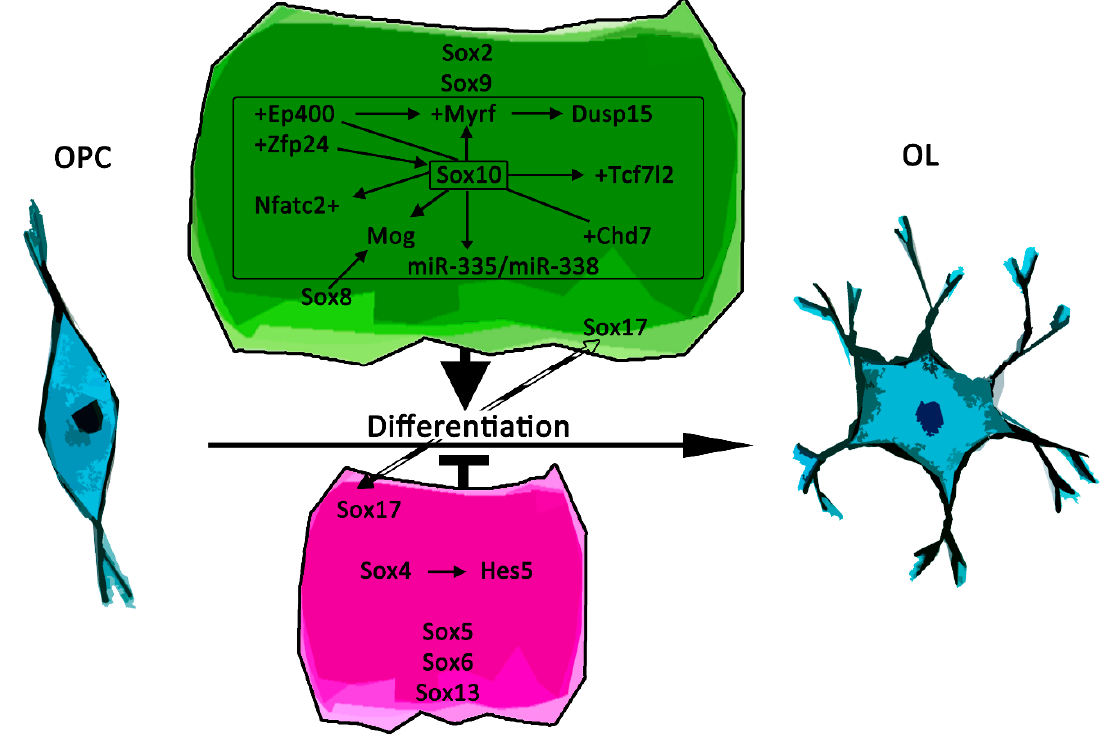
Figure 2. Schematic representation of recently described Sox protein functions in oligodendroglial differentiation. Positive effects are shown in green, negative effects in magenta. Arrows in colored frames indicate transcriptional regulators and mediators of Sox protein function, while proteins that directly interact with Sox proteins are further annotated by “+”. Dashed arrow between negative and positive regulation indicates switch of Sox protein function. OL = oligodendrocyte.